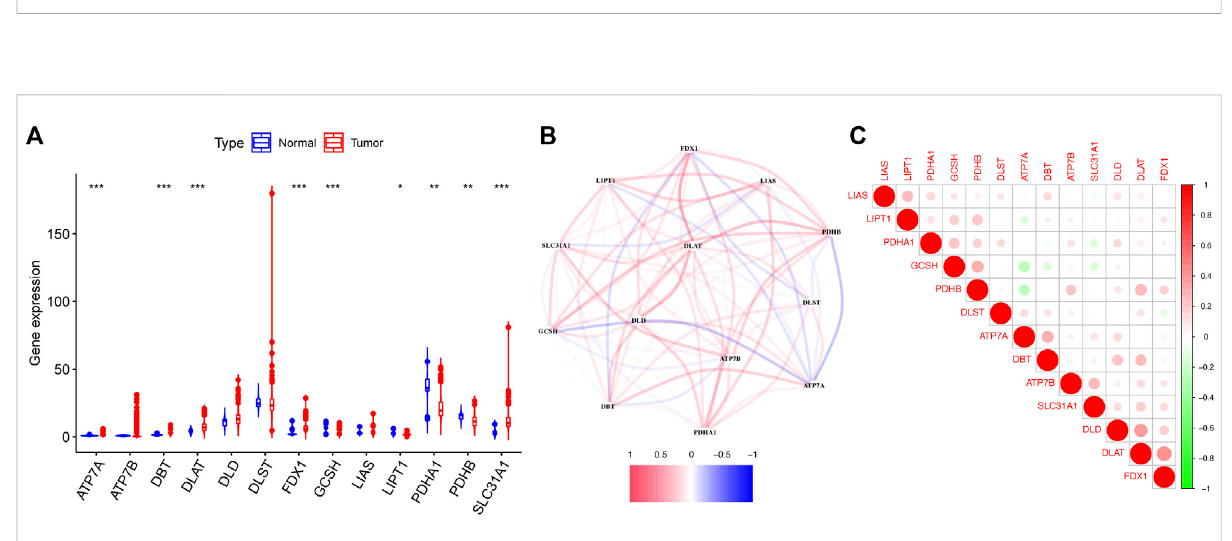
FIGURE 2 Expression of 13 cuproptosis-related genes in TCGA-GTEx cohort. (A) Violin plot presented the distinct expression of cuproptosis-related genes between normal cervical tissues and cervical tumor tissues. (B) PPI network showed the interactions among cuproptosis-related genes. (C) Correlations among cuproptosis-related